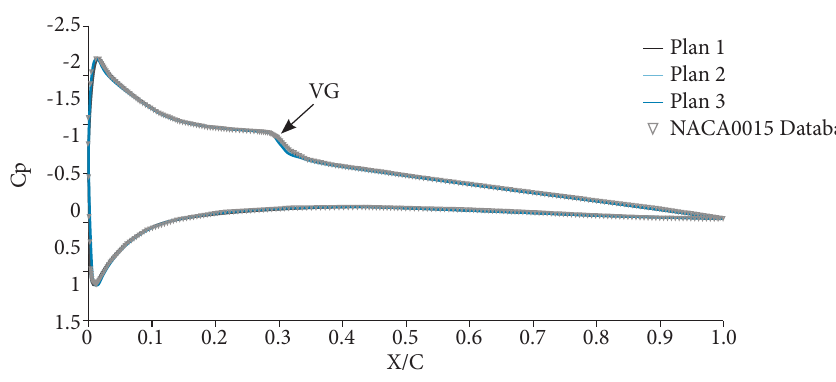
Figure 18. Pressure distribution along Plans 1, 2 and 3 for NACA 0015 airfoil with and without VG in Re c = 2.38 × 10 5 and AoA =